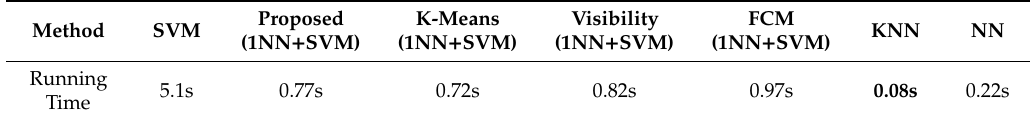
Table 3. Running time